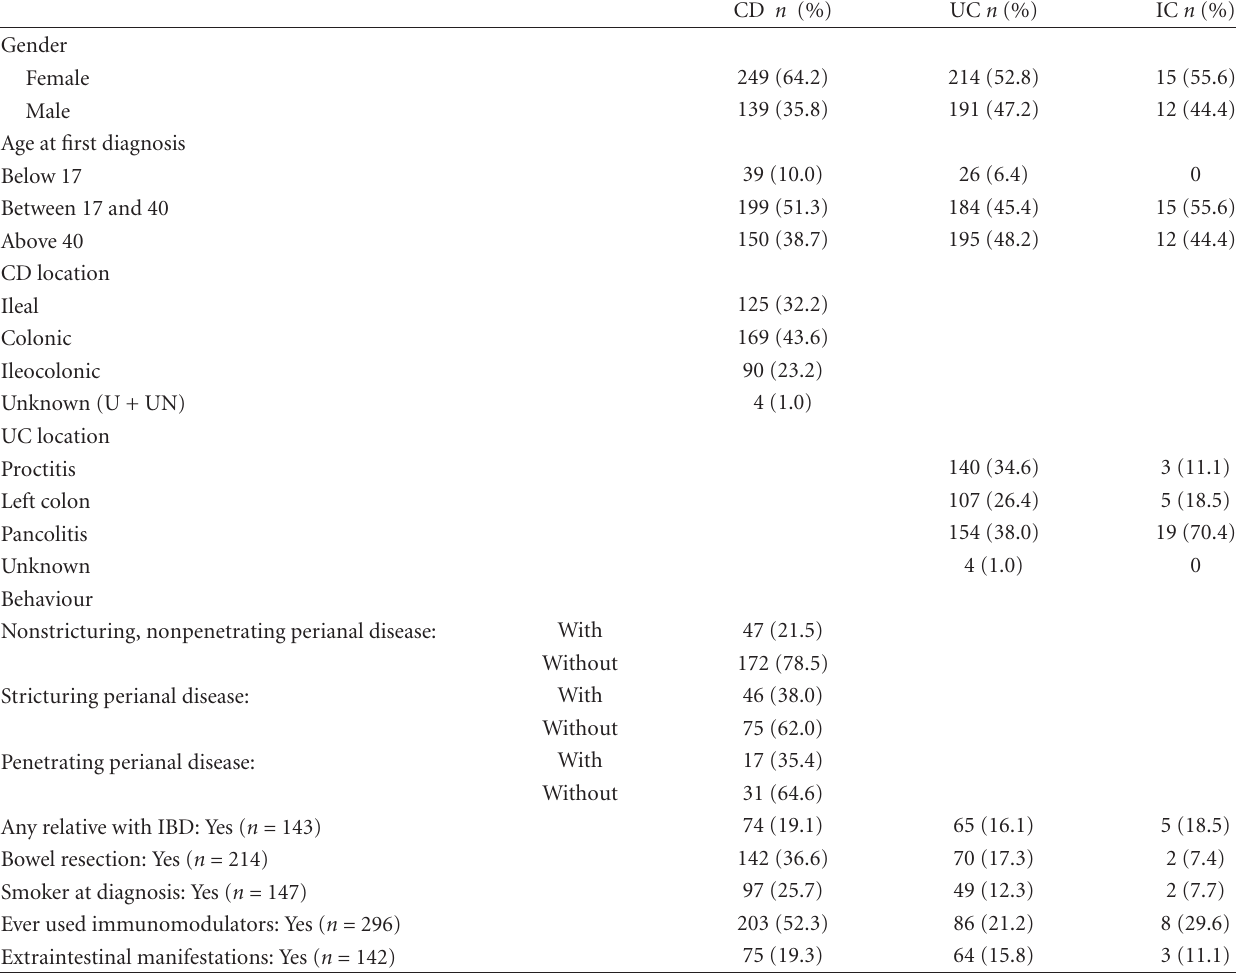
Table 2: Summary of clinical and demographic data for the set of Caucasian IBD patients.